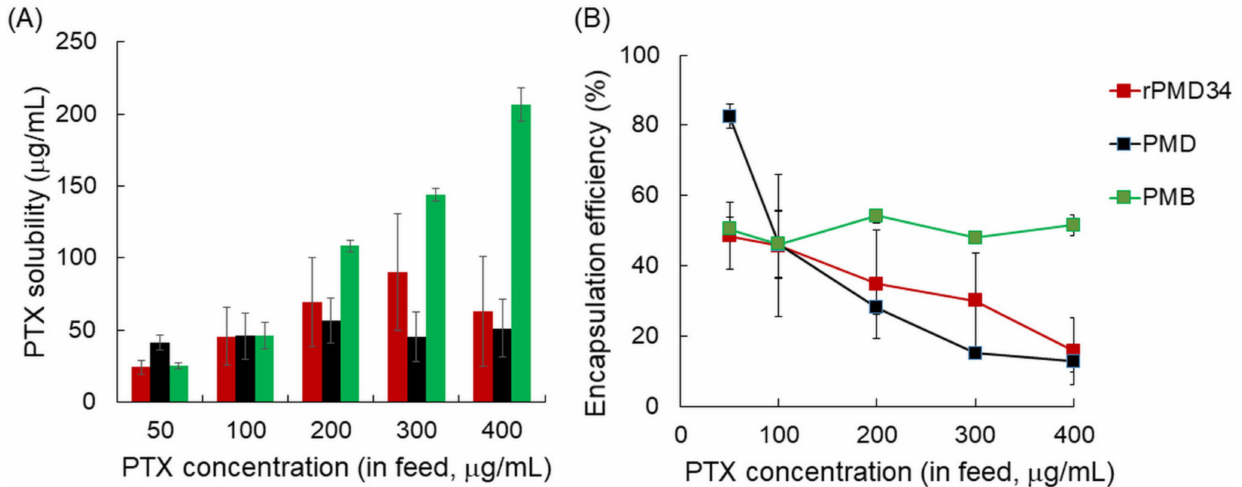
Figure 5. ( A ) PTX solubility and ( B ) PTX encapsulation efficiency (%) of MPC polymers mixed with different concentrations of PTX solutions.